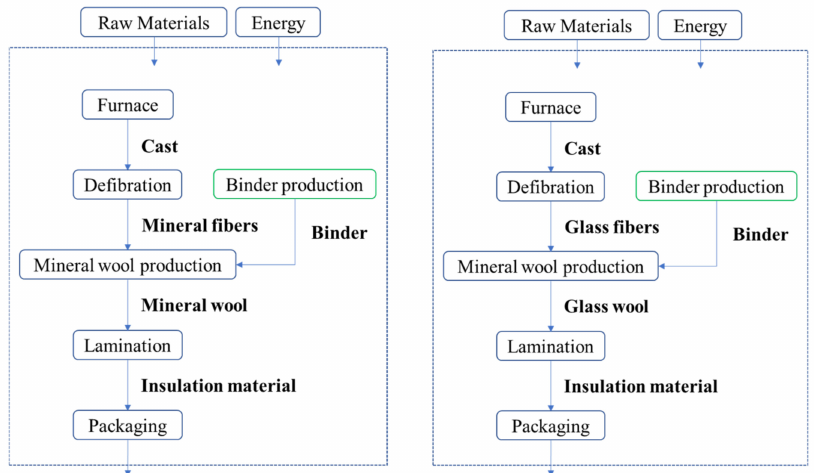
Figure 4. Cradle-to-gate flow diagram of wool-based material.